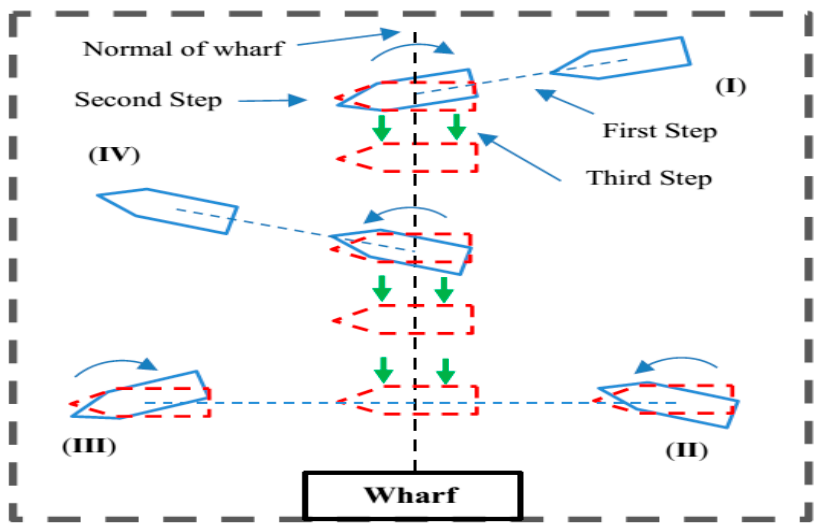
Figure 4. Selection of the maneuvering method such that with the shortest distance from the ship to the wharf. the wharf.